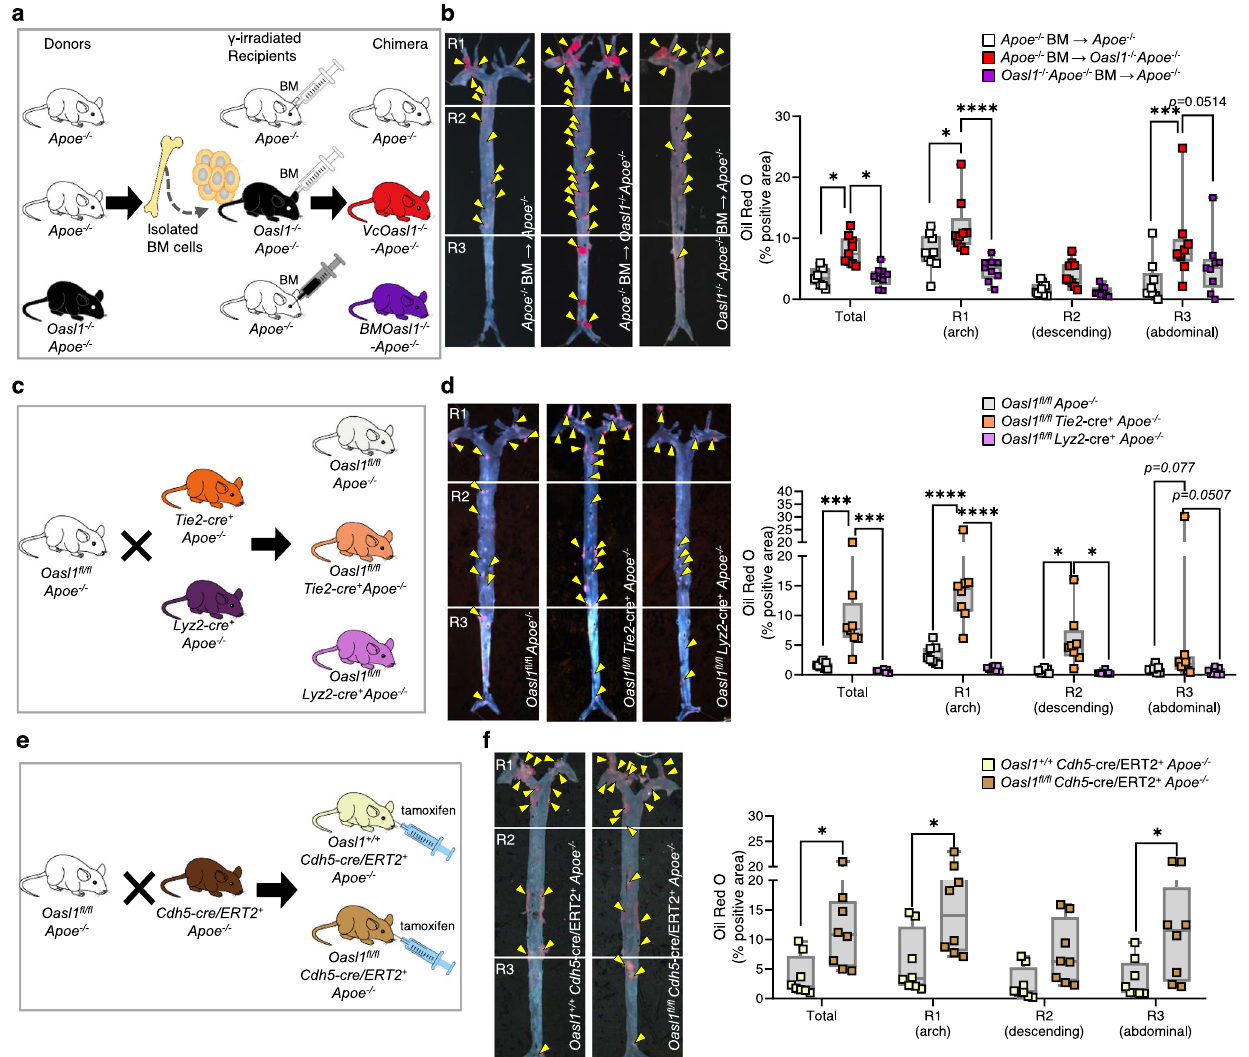
Fig.3|VascularEC-speci fi c Oasl1 de fi ciencyexacerbatesatheroscleroticplaque formation. a , b Apoe − / − and Oasl1 − / − Apoe − / − recipient mice, reconstituted with bone marrow(BM)from Apoe − / − miceor Oasl1 − / − Apoe − / − mice,after γ -irradiationwerefeda normal chow diet (NCD) for 28 weeks. a Experimental scheme. b Left: Oil red O-stained lesions in en face preparations of whole aortas ( p =0.0145; p =0.0148, n =9 per group). Yellow arrowhead: plaque in aorta. Right: Quantitation of oil red O-stained areas in the whole aorta and separate regions, including the aortic arch (R1; p =0.0212; p <0.0001),descending(R2; p =0.2079; p =0.1467)andabdominal (R3; p =0.0002) regions. c , d Oasl1 fl / fl Apoe − / − , Oasl1 fl / fl Tie2 -cre + Apoe − / − and Oasl1 fl / fl Lyz2 -cre + Apoe − / − micewerefedaNCDfor28weeks.( c )Experimentalscheme. d Left: Oil red O-stained lesions in en face preparations of whole aortas ( p =0.0009; p =0.0002,n=8pergroup).Yellowarrowhead:plaqueinaorta.Right:Quantitation